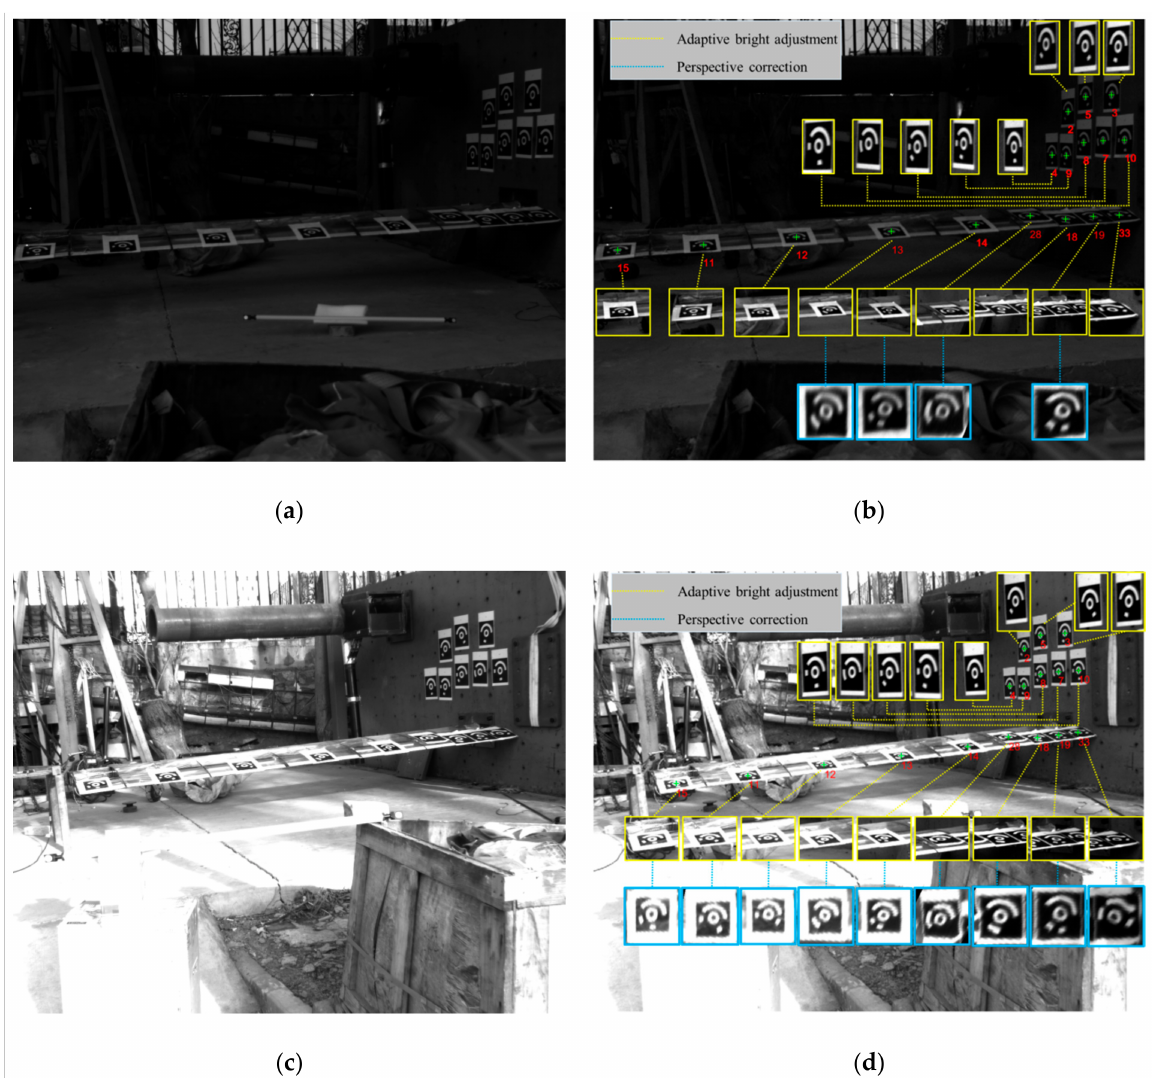
Figure 20. Wing deformation experiment based on CCCTs in field work: ( a ) Underexposure of the image; ( b ) Identification of CCCTs; ( c ) Overexposure; ( d ) Identification of